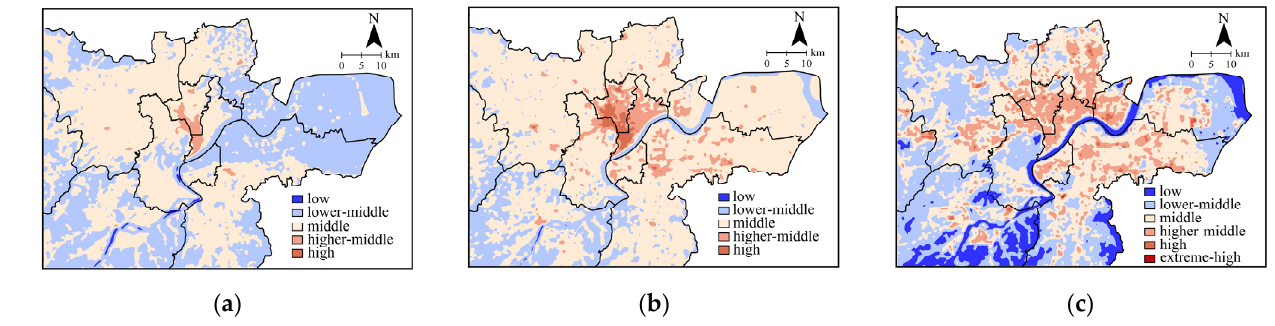
Figure 6. Distribution of Hangzhou’s thermal environment during the three periods in the daytime: